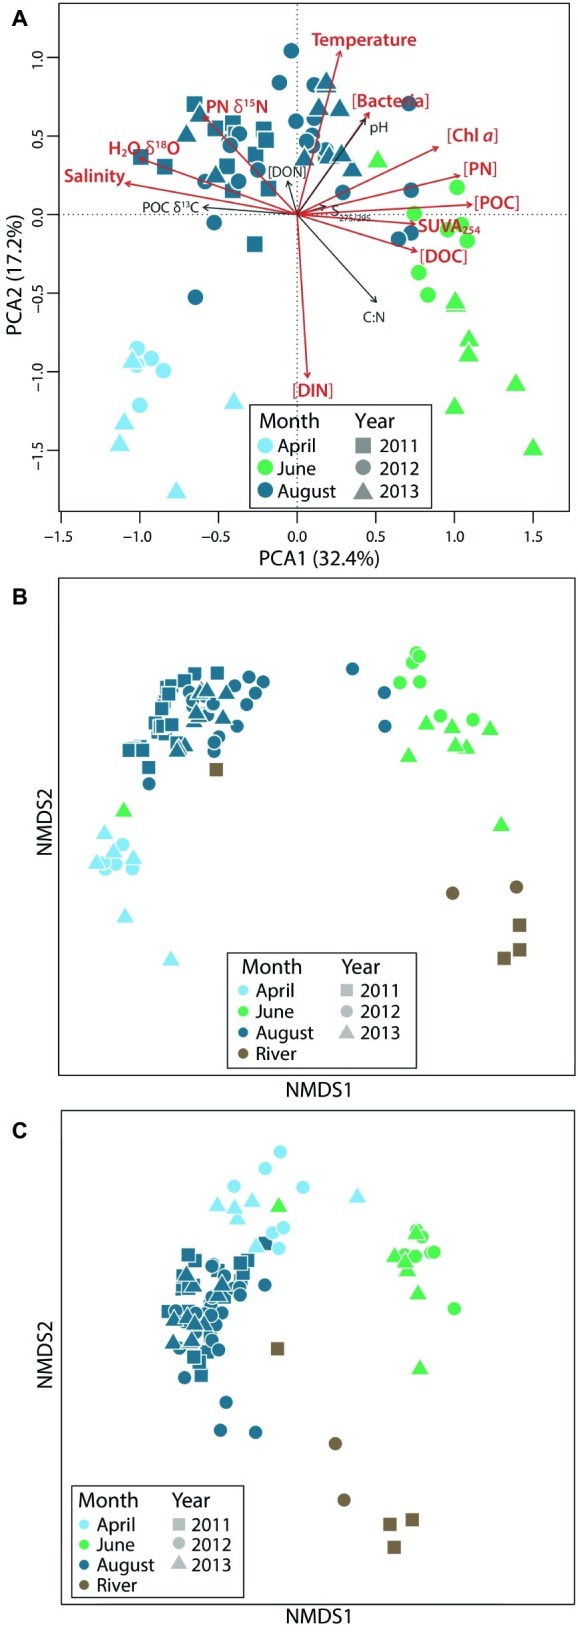
Environmental and microbial community variability across seasons. Principal component analysis of (A) physico-chemical data and nonmetric multidimensional scaling plots showing (B) bacterial and (C) protistan beta diversity (based on Bray-Curtis distances) highlight seasonal variation.